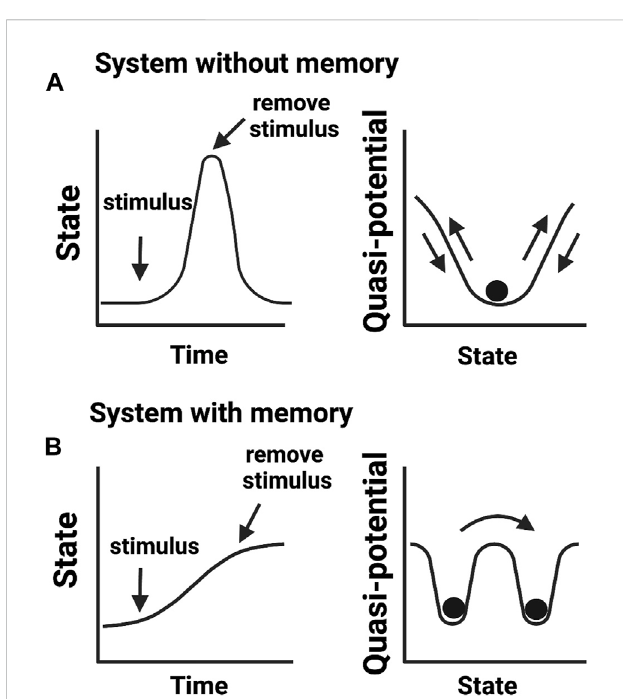
FIGURE 2 Biological memory in cellular systems. (A) Adaptive cellular response withoutamemory output. Upon encountering astimulus (e.g., environmental stress), cells change their activities in response to altering conditions but return to a basal state in the absence of a stimulus. (B) Cellular response that confers memory. After encountering a stimulus, cells transit to a new state adapting to an imposed change. In this scenario, cells fail to return to the initial basal state even in the absence of an experienced stimulus. Cells transited to a new state but “ remember ” previous events. Right panels show quasi-potential energy landscapes (i.e., the energy barrier a cell needs to reorganize its intermolecular activities) associated with cellular memory